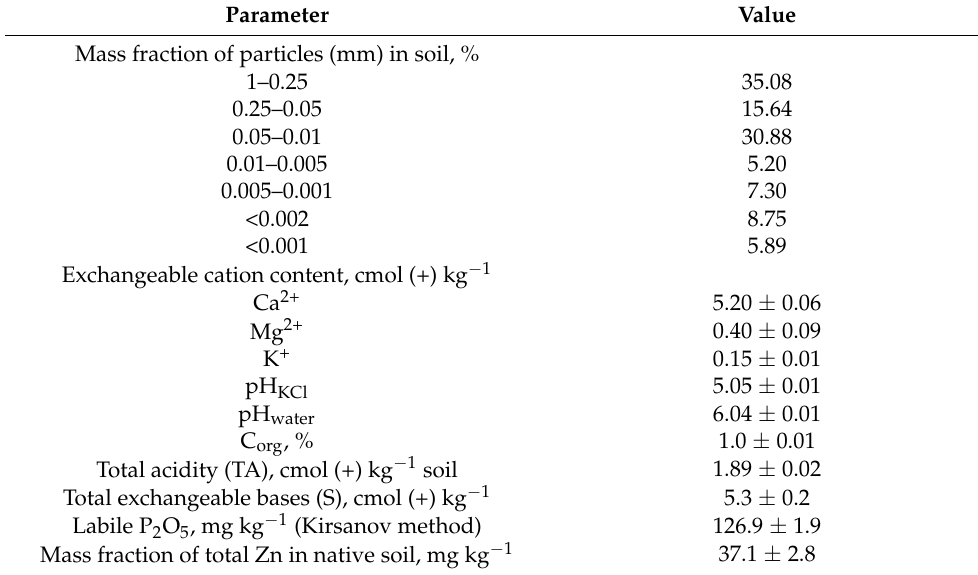
Table 1. Main characteristics of Albic Retisol (Loamic, Ochric) soil (mean ± standard deviation). Parameter Value Mass fraction of particles (mm) in soil,